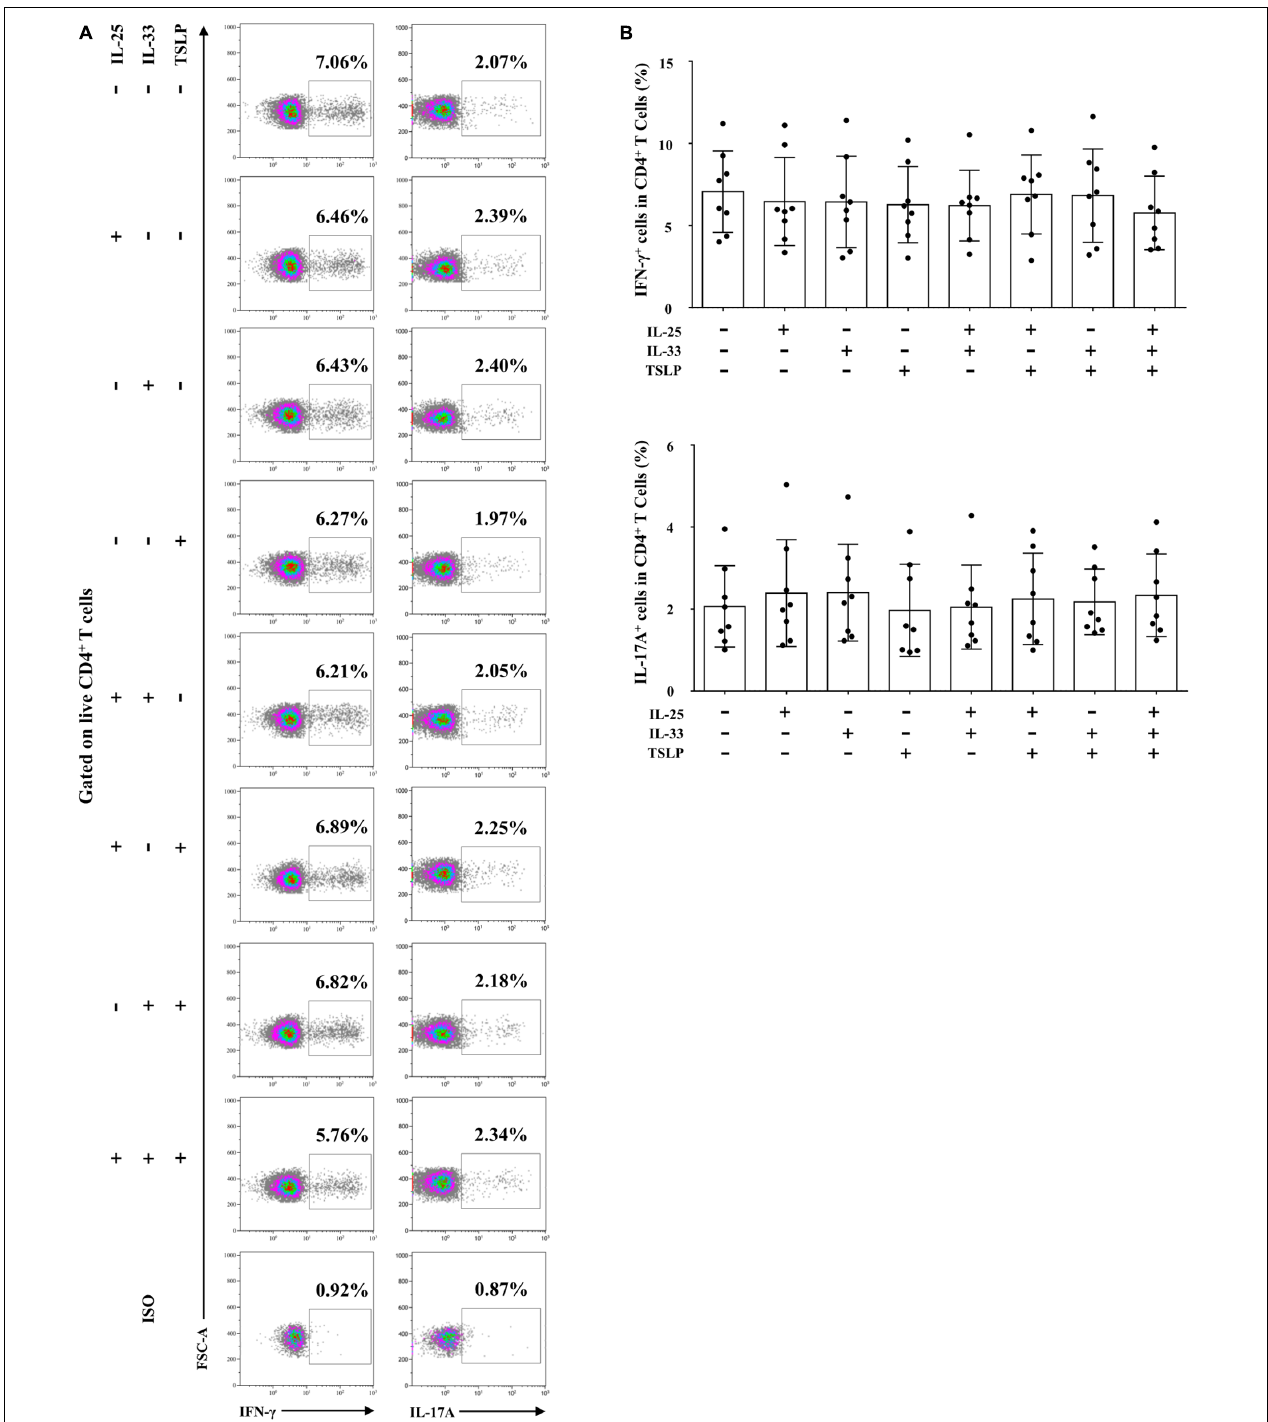
FIGURE 6 | IL-25, IL-33, and TSLP had no effect on the pro-Th1/Th17 function of AR-derived mo-DCs. (A) Representative flow plots of IFN- γ and IL-17 expression by CD4 + T cells from HC subjects ( n = 8) co-cultured for 5 days with Der.p1-induced mo-DCs from AR subjects ( n = 8). Prior to co-culture, Der.p1-induced mo-DCs were stimulated with IL-25, IL-33, and TSLP, singly or in combination, for 24 h. (B) Quantification of percentages of IFN- γ + and IL-17 + cells in CD4 + T cells. Data are expressed as means ± SD. Significant differences were tested using the paired t -test between control and cytokine stimulation groups, and using Student’s t -test between cytokine stimulation